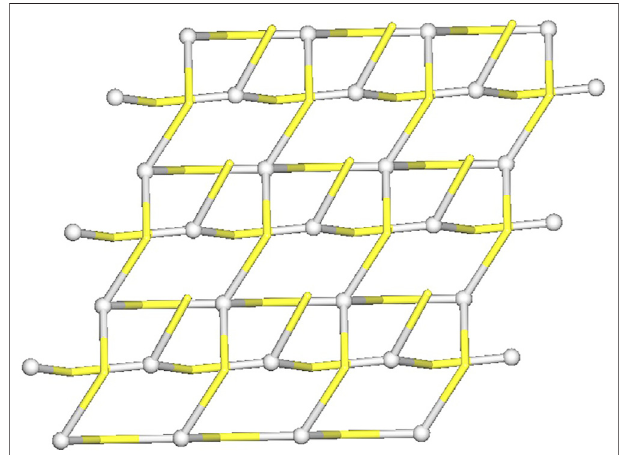
FIGURE 7 | Topological representation of a mononodal 4-linked metal- organic layer in [Ag(I)-Tazo 2 ] with a sql topology, decorated with 2C1 chains; rotated view along the b axis; Ag1/Ag2 centers (gray balls), centroids of TazoH/Tazo − moieties (yellow).